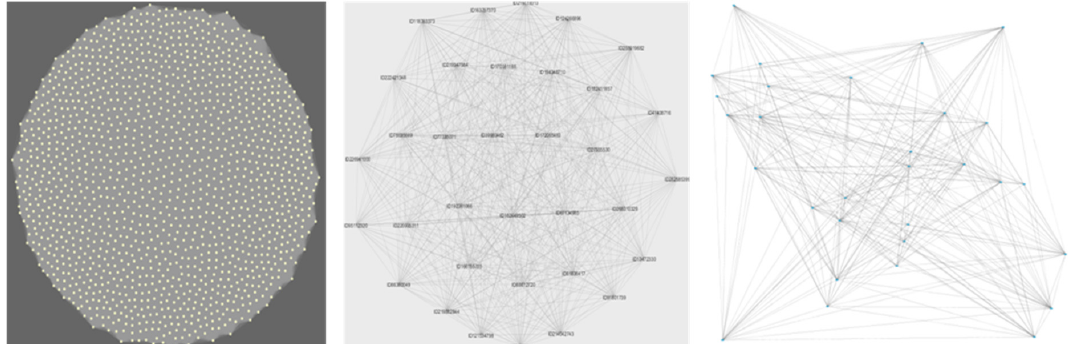
Figure 2. Structural organization of microarray genes by weighted gene co-occurrence network analyses (WGCNA) modules. First panel: Turquoise functional module; Second panel: Royal Blue functional module. Each colour represents a WGCNA module built from functional genes that tend to co-occur (see Methods section for full description); Third panel: Phylo1 module from the WGCNA network built based on only phylogenetic markers. The figure is shown to highlight the underlying structure of a random network.